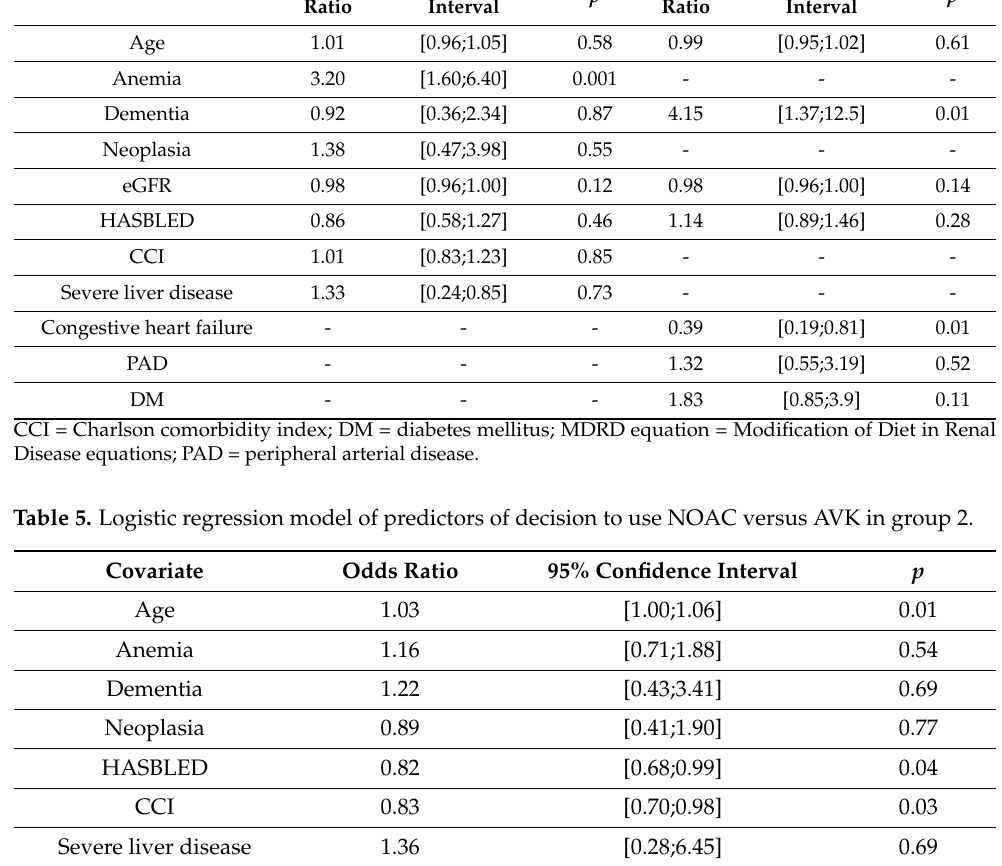
Table 4. Logistic regression model of predictors of decision not to prescribe anticoagulants. Group 1 Covariate